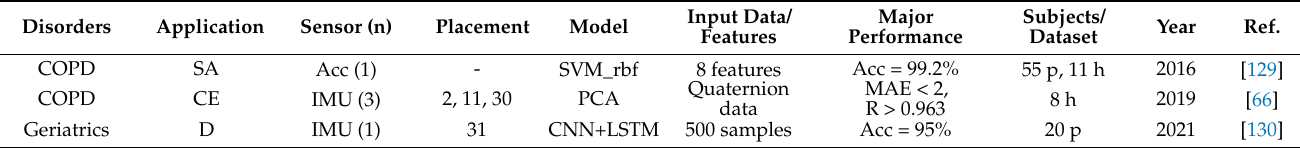
Table 5. Other disorders and general